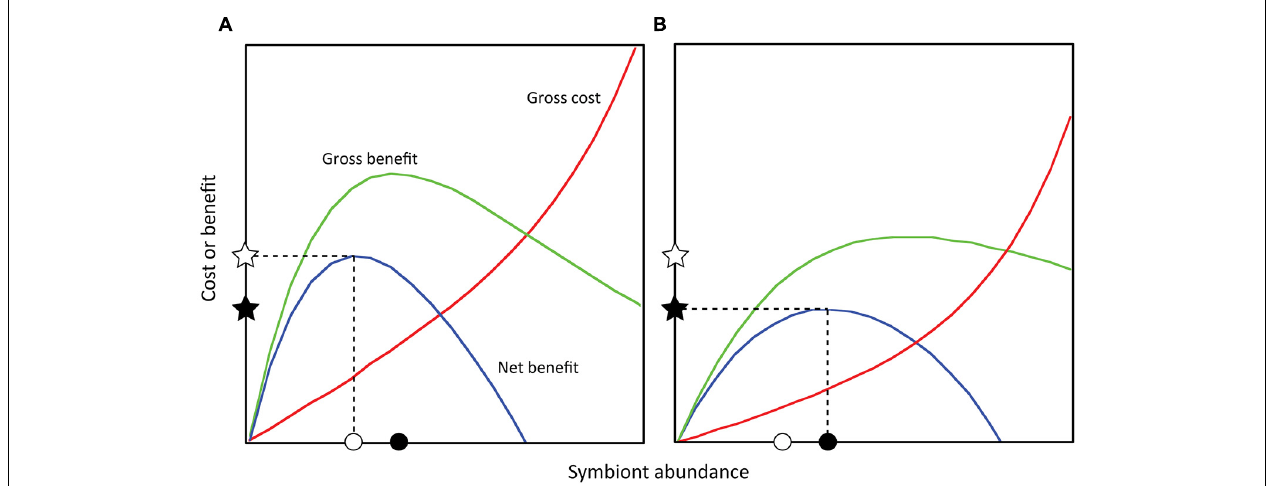
A vs. B ) such that a particular optimal abundance exists for a particular set of conditions. Note that in (A) , the optimal symbiont abundance is lower than in (B) , but the corresponding net benefit is higher. Within either set of conditions, symbiont abundances above or below the optimum result in decreasing net benefit. Net benefits may be predictive of energetic status, growth rates, or reproductive